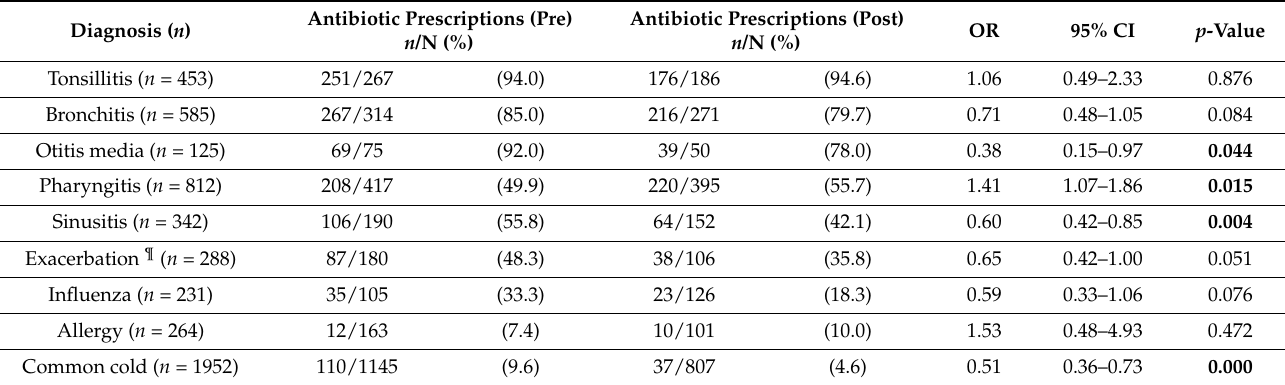
Table 4. Diagnosis-specific antibiotic prescribing (overall) for the most common diagnoses, pre- and post-intervention ( n = 5296 eligible aRTC